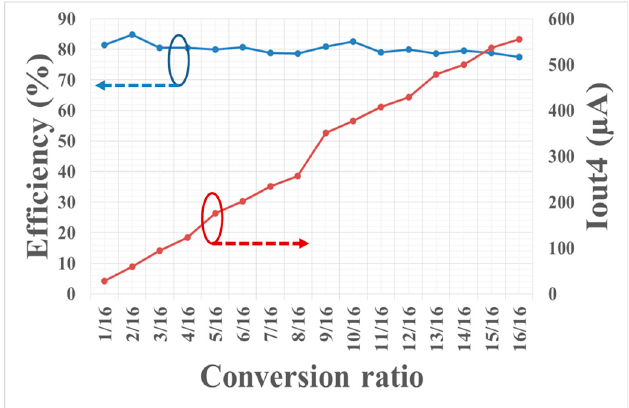
architecture versus the temperature when V in =1.5 V, F SW = 50 MHz, C = 50 pF, R L = 2 K Ω .